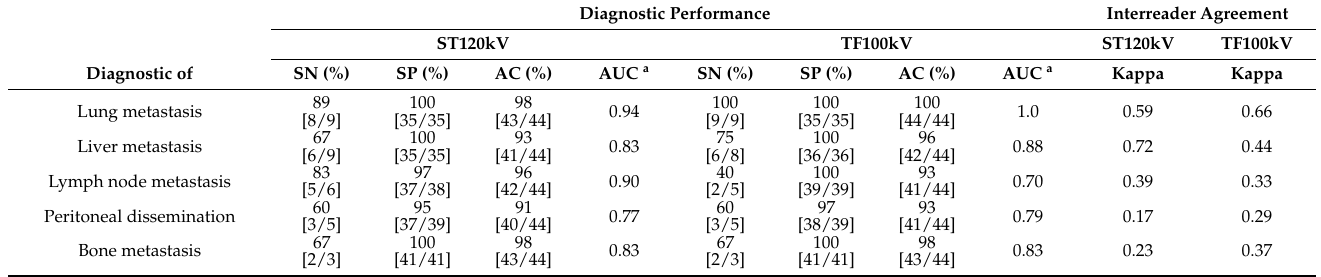
Table 5. Subjective assessment of diagnostic performance with Kappa